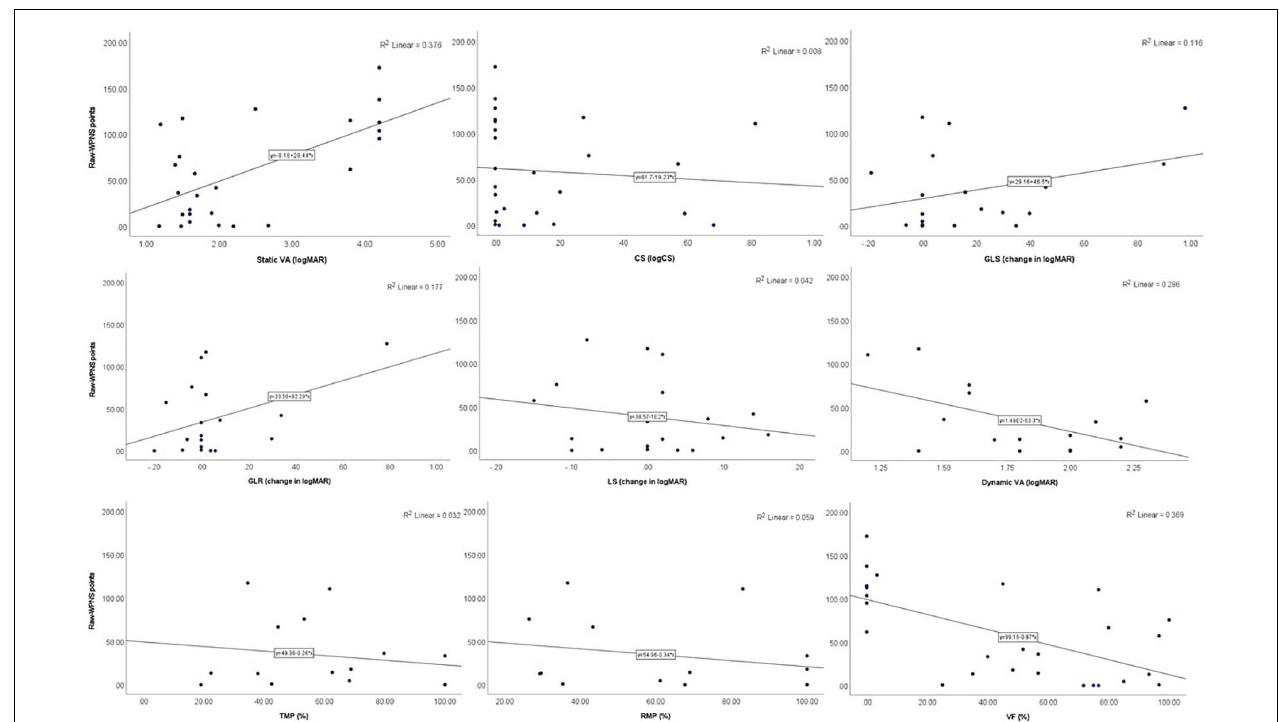
FIGURE 2 | Scatter plots showing the relationships between raw-WPNS points and visual functions.